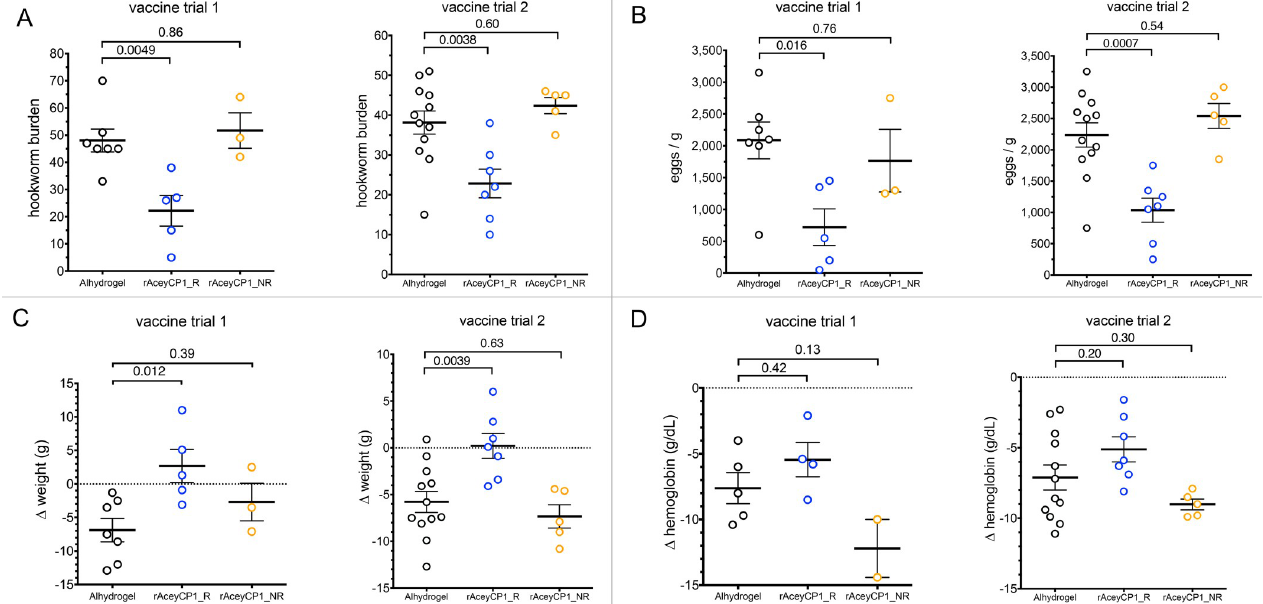
Fig 7. Efficacy results for rAceyCP1 serum IgG responders and nonresponders analyzed as separate groups. Comparisons between rAceyCP1/Alhydrogel serum IgG responders (blue dots) and serum IgG nonresponders (orange dots) with Alhydrogel controls (black dots) of (A) mean hookworm burdens, (B) mean FEC, (C) mean change in weight after hookworm infection and (D) mean change in hemoglobin concentration after hookworm infection R, responders; NR, nonresponders.